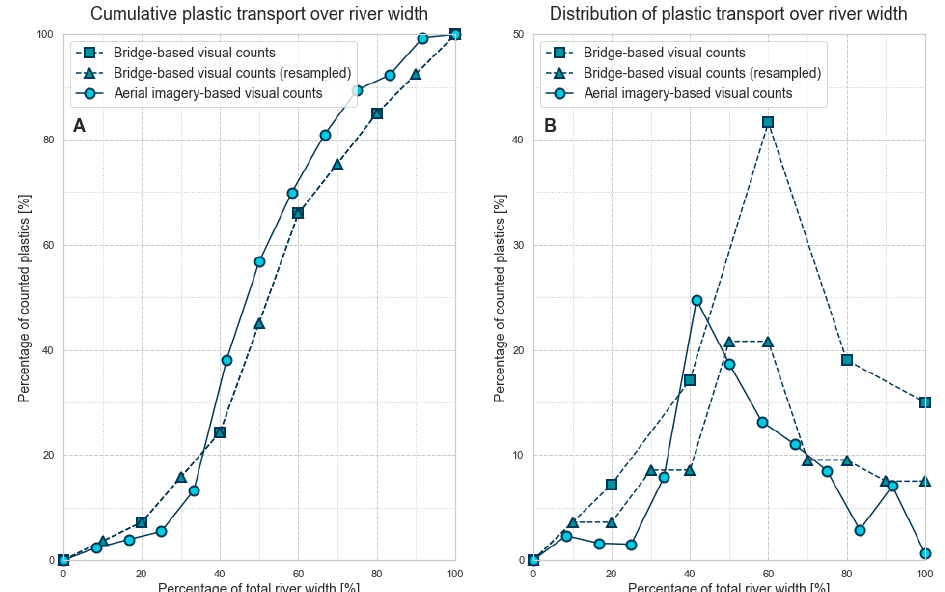
Figure 6. ( A ) Plot of the cumulative plastic transport over the river width, measured with both the aerial survey and the bridge-based visual survey. The cumulative plastic transport over the river width for resampled visual survey data is also indicated. ( B ) Overview of the distribution of plastic transport over the river width, measured using the aerial survey and the bridge-based visual counts. The distribution of plastic transport over the river width using resampled visual survey data is also